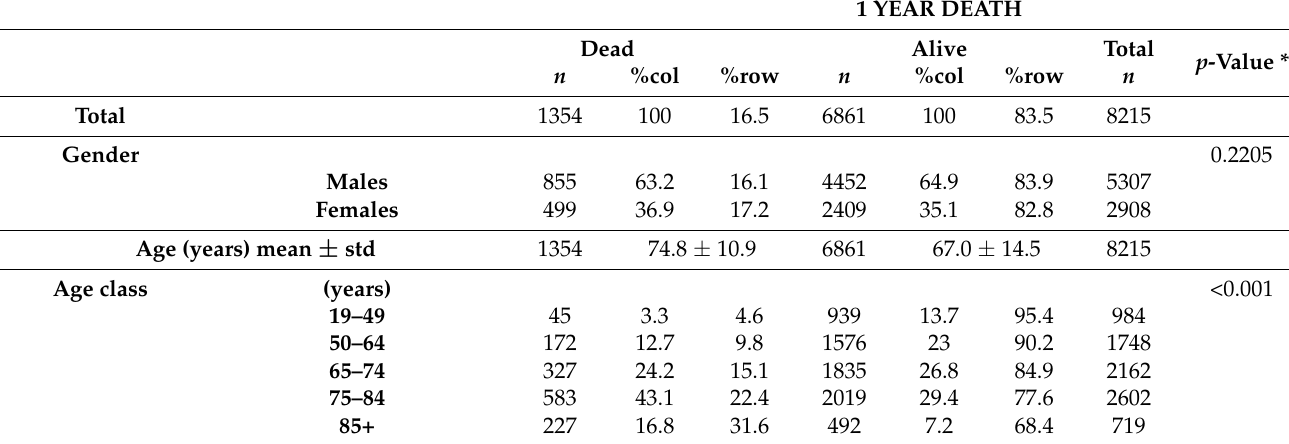
Table 3. Distribution of socio-demographic, clinical, and care-related characteristics according to dead/alive status at 1 year mortality. Incident hemodialysis patients from RRDTL Lazio Region (Italy)